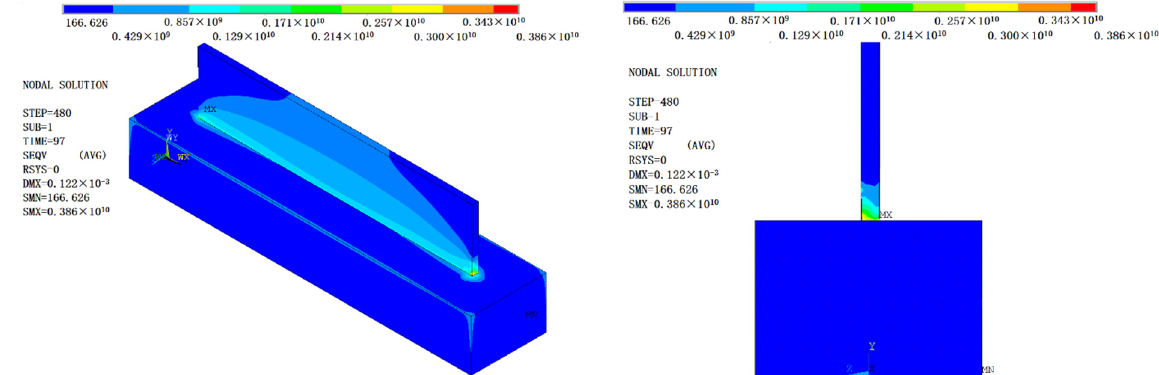
Figure 21. Von Mises residual stress distribution and deformation of thin-walled parts after side milling.